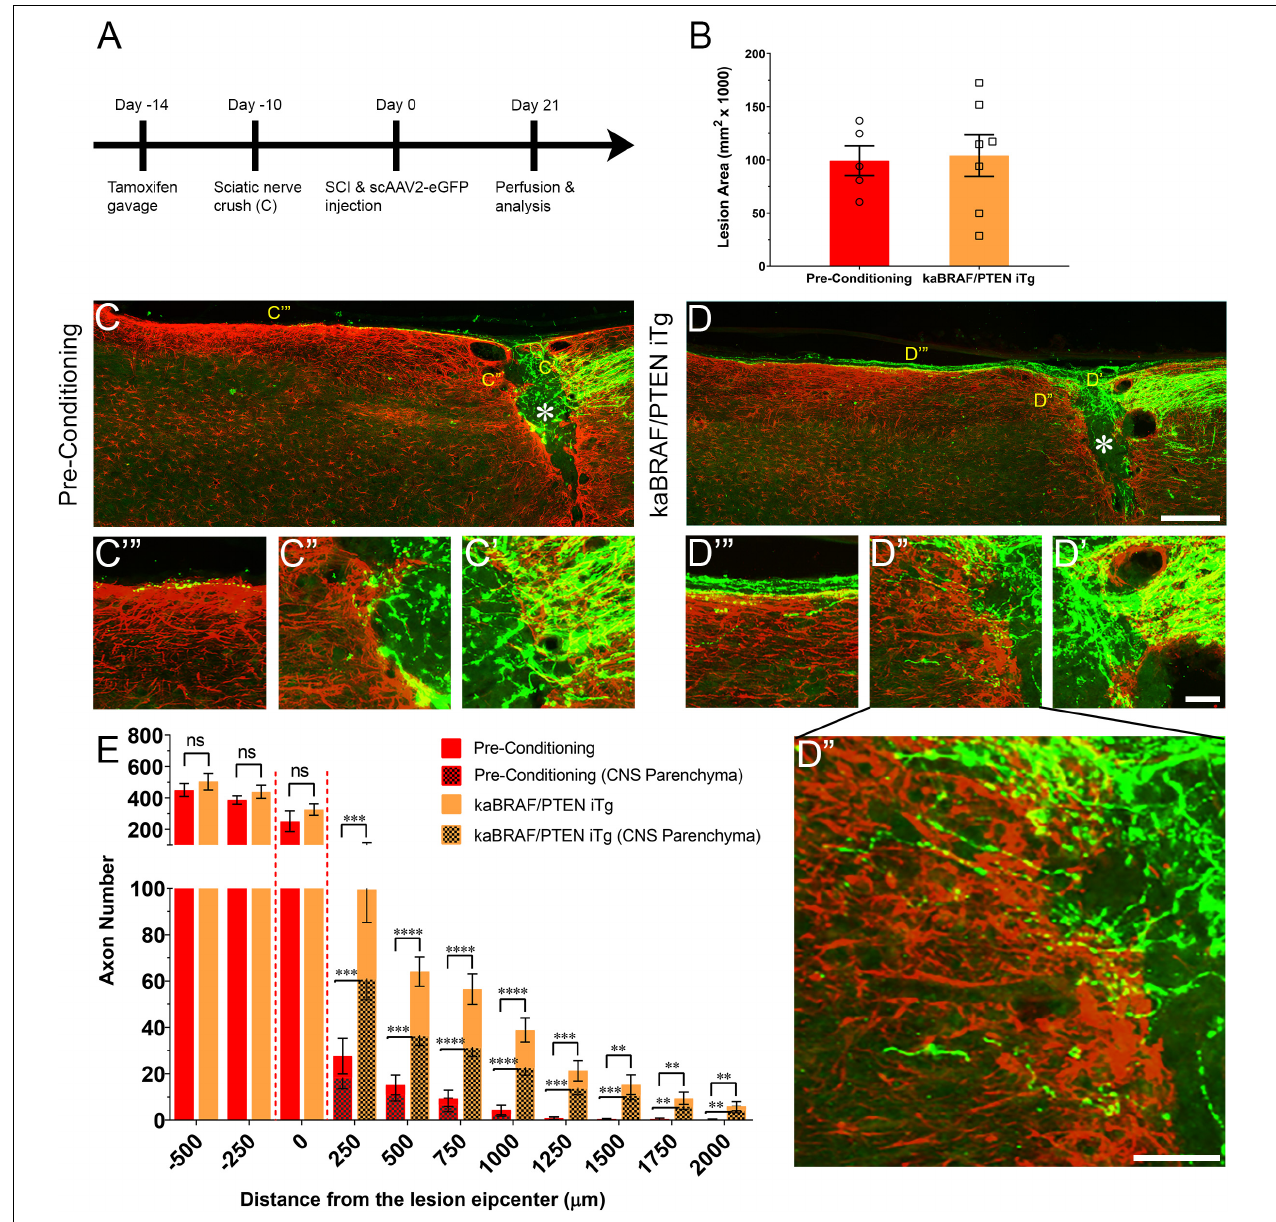
FIGURE 2 | Concomitant B-RAF activation and PTEN deletion enhances DC axon regeneration more effectively than a pre-conditioning lesion. (A) Schematic diagram showing the experimental timeline. Four days after the first tamoxifen gavage one group of WT mice underwent right sciatic nerve crush (pre-conditioning lesion). WT mice with a pre-conditioning lesion and kaBRAF/PTEN iTg mice without pre-conditioning lesion underwent dorsal SCI and scAAV2-eGFP injection into the right L4 and L5 DRGs to label regenerating DC axons 2 weeks after the first tamoxifen gavage. (B) Quantitative analysis of the SCI lesion area in kaBRAF/PTEN iTg group versus pre-conditioning group. (C–C (cid:48)(cid:48)(cid:48) ) Representative images of a pre-conditioning mouse spinal cord showing regenerating DC axons reaching the lesion epicenter with a few terminating just rostral to the lesion site. ∗ Indicates lesion epicenter. (D–D (cid:48)(cid:48)(cid:48) ) Representative images of a kaBRAF/PTEN iTg mouse spinal cord showing robust DC axon regeneration. Many regenerating DC axons penetrate the lesion epicenter and extend long distances rostral to the lesion site. ∗ Indicates lesion epicenter. (E) Quantitative comparison of regenerated DC axons in kaBRAF/PTEN iTg mice versus WT pre-conditioning lesion group. Significantly greater DC axon regeneration is evident at multiple distances rostral to the lesion in kaBRAF/PTEN iTg mice. 250 µ m: ∗∗∗ P = 0.0004, df = 10; 500 µ m: ∗∗∗∗ P < 0.0001, df = 10; 750 µ m: ∗∗∗∗ P < 0.0001, df = 10; 1,000 µ m: ∗∗∗∗ P < 0.0001, df = 10; 1,250 µ m: ∗∗∗ P = 0.0005, df = 10; 1,500 µ m: ∗∗ P = 0.0035, df = 10; 1,750 µ m: ∗∗ P = 0.005, df = 10; 2,000 µ m: ∗∗ P = 0.0100, df = 10; two-way ANOVA with repeated measures. [ (E) patterned] Quantitative analysis of regenerated DC axons in CNS parenchyma rostral to the injury site in kaBRAF/PTEN iTg mice versus WT pre-conditioning lesion group. Significantly increased DC axon regeneration is evident at multiple distances up to 2,000 µ m rostral to the lesion in kaBRAF/PTEN iTg mice. 250 µ m: ∗∗∗ P = 0.0008, df = 10; 500 µ m: ∗∗∗ P = 0.0001, df = 10; 750 µ m: ∗∗∗∗ P < 0.0001, df = 10; 1,000 µ m: ∗∗∗∗ P < 0.0001, df = 10; 1,250 µ m: ∗∗∗ P = 0.0006, df = 10; 1,500 µ m: ∗∗∗ P = 0.0004, df = 10; 1,750 µ m: ∗∗ P = 0.0054, df = 10; 2,000 µ m: ∗∗ P = 0.0071, df = 10; two-way ANOVA with repeated measures. n = 5 (pre-conditioning), and 7 (kaBRAF/PTEN iTg). Scale bars, 250 µ m (C,D) , 50 µ m (C (cid:48) –C (cid:48)(cid:48)(cid:48) ,D (cid:48) –D (cid:48)(cid:48)(cid:48) ) , ns, not